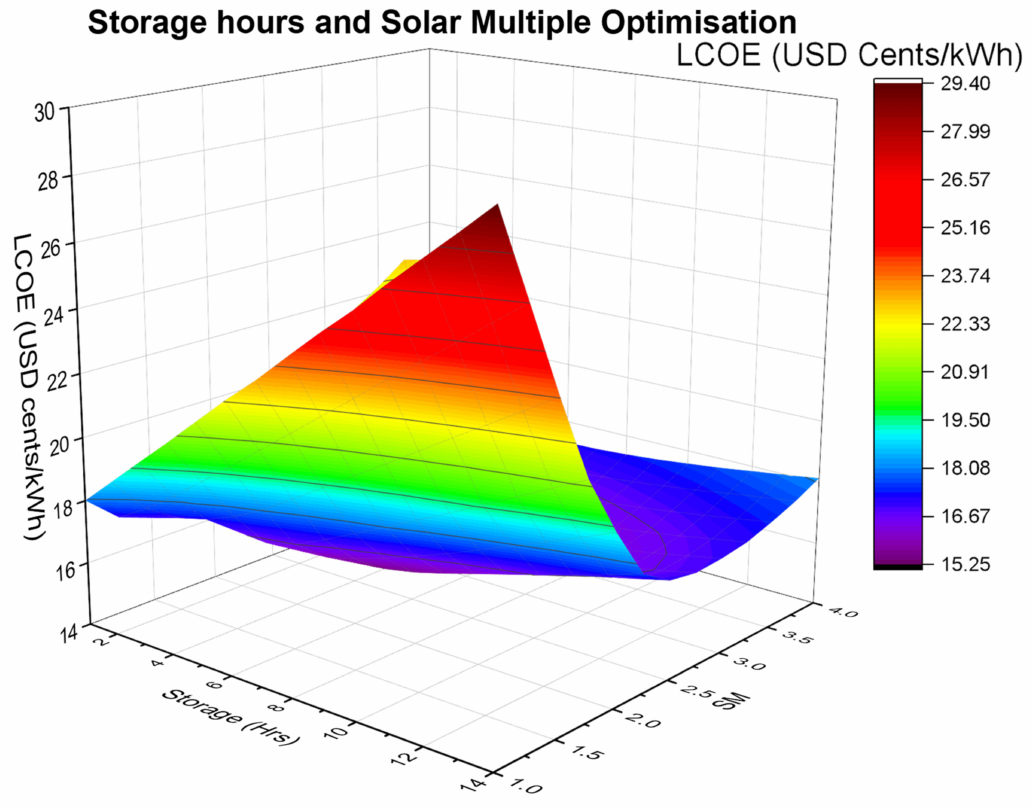
Figure 26. Three-dimensional graph showing the optimisation of the storage hours and the solar